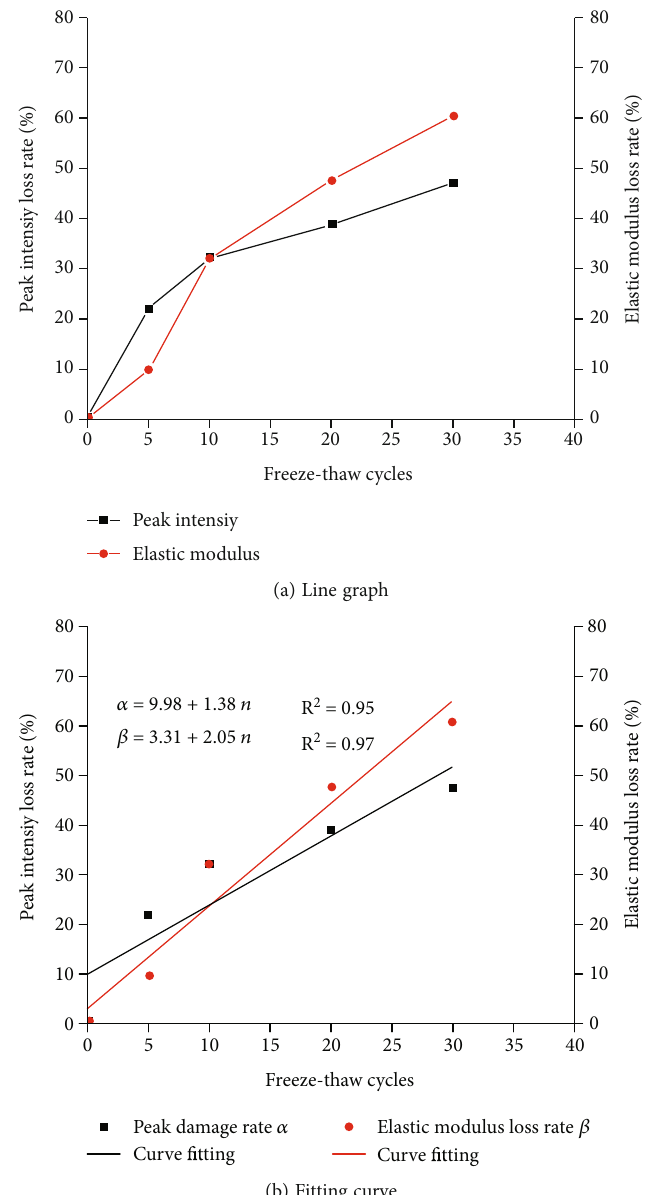
Figure 5: Relationships between freeze-thaw cycle counts and the loss rates of characteristic mechanical